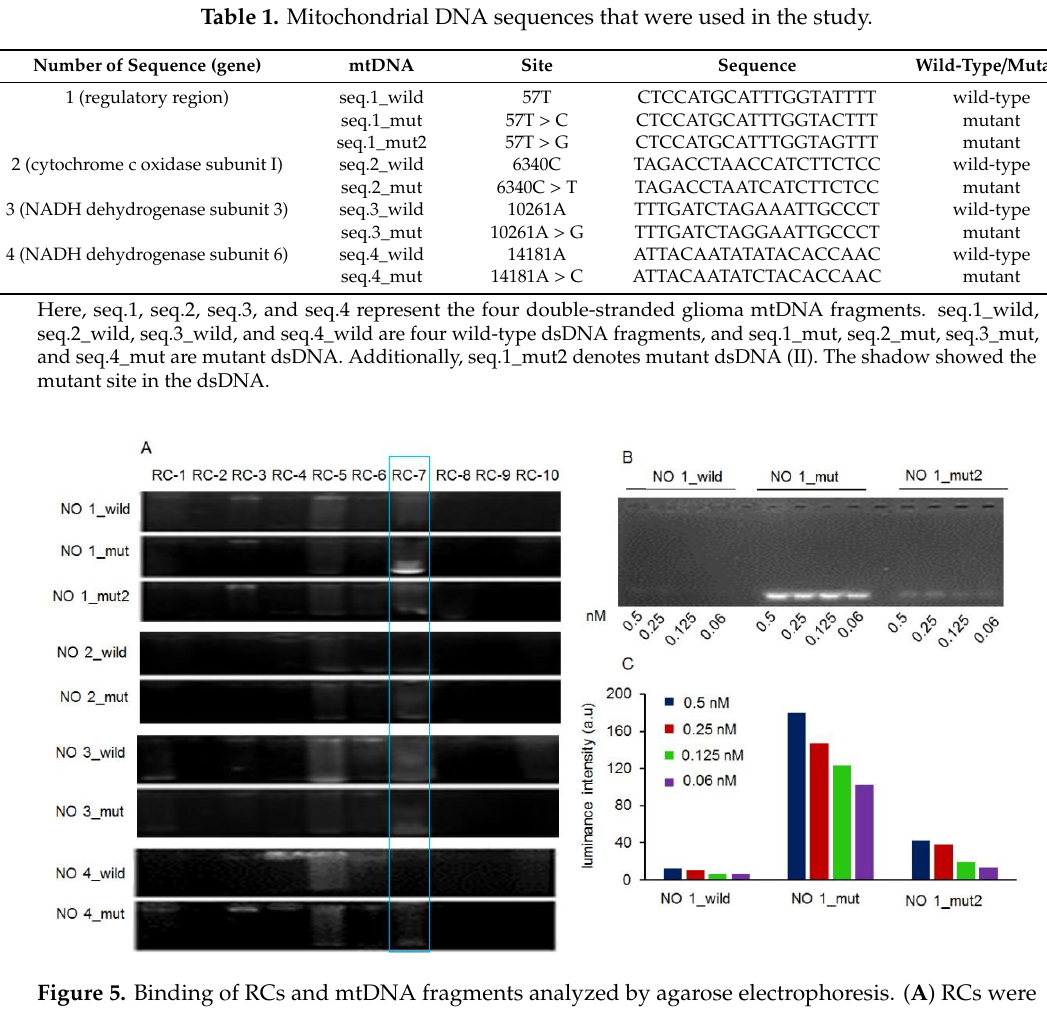
Table 1. Mitochondrial DNA sequences that were used in the study.